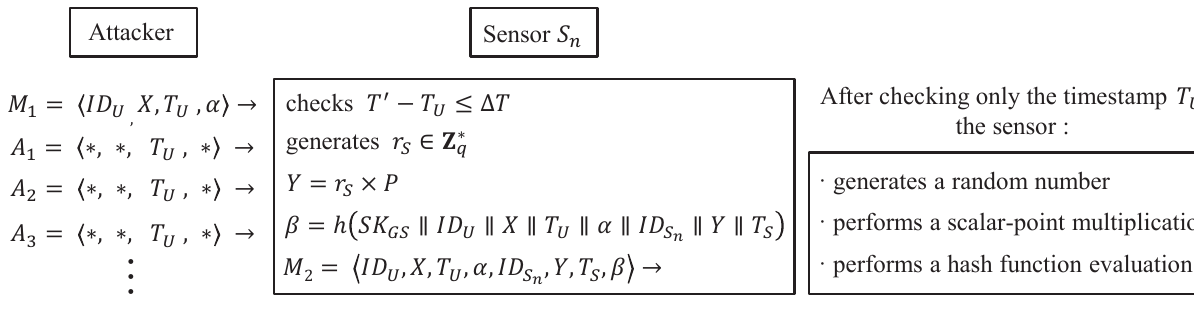
Figure 6. A sensor energy exhausting attack on Shi et al .’s protocol.